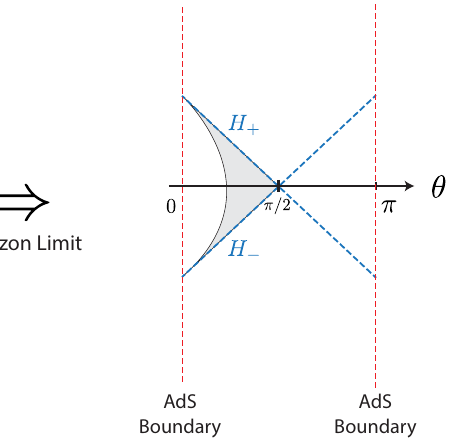
Figure 6 . On the left we see the maximally extended Penrose diagram of the near-extremal Reissner-Nordstrom black hole. Notice that in this case the future (past) horizon H + ( H − ) is actu- ally the past (future) horizon for the asymptotic region on the right. Taking the near horizon limit we obtain the AdS 2 × S d − 2 space-time on the right, see [27]. The gray shaded region corresponds to the section of the black hole that is well approximated by AdS 2 × S d − 2